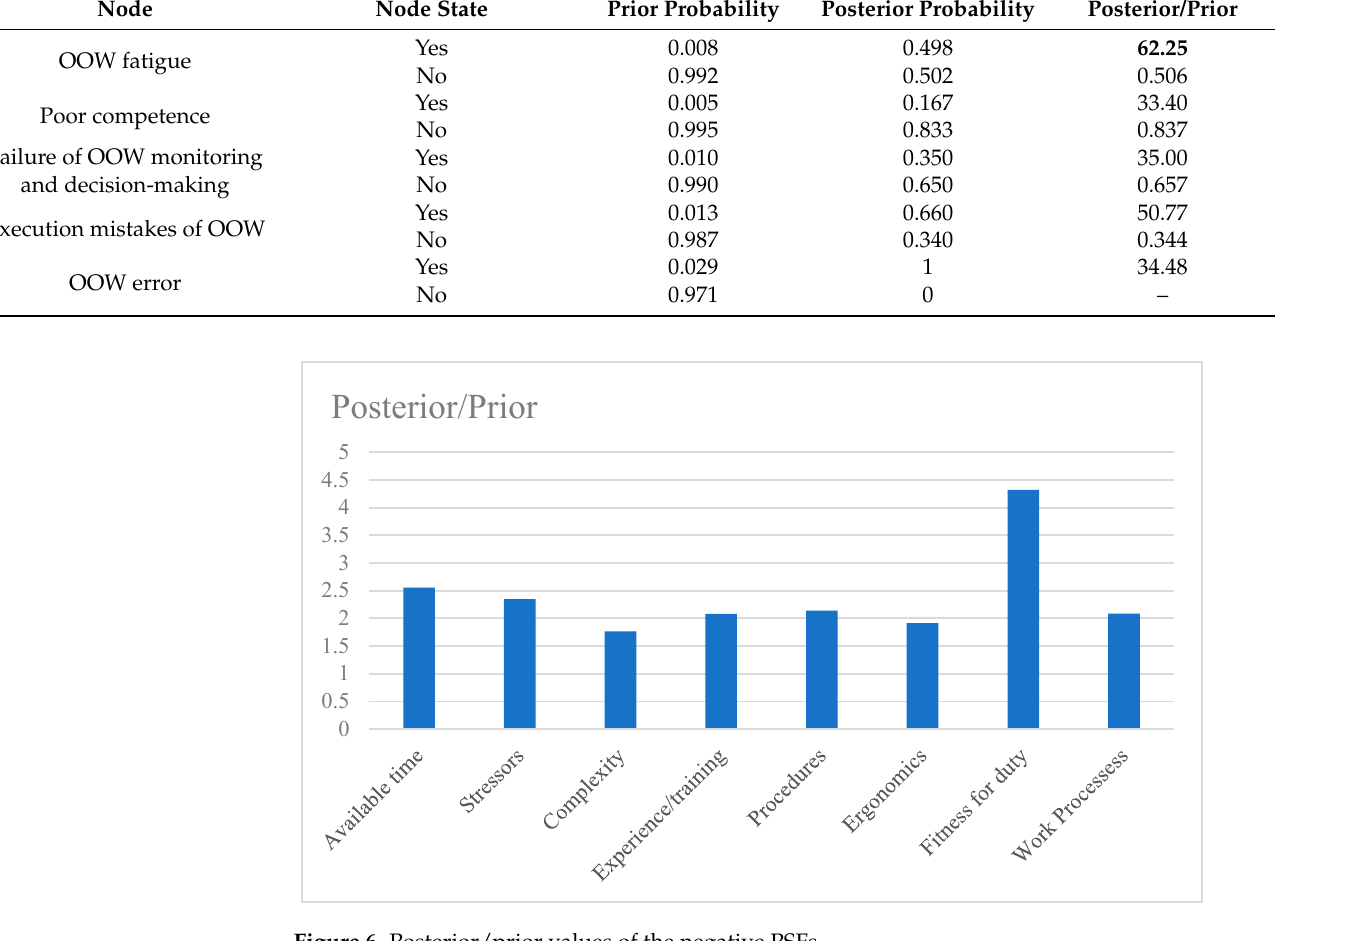
Figure 6. Posterior/prior values of the negative PSFs.